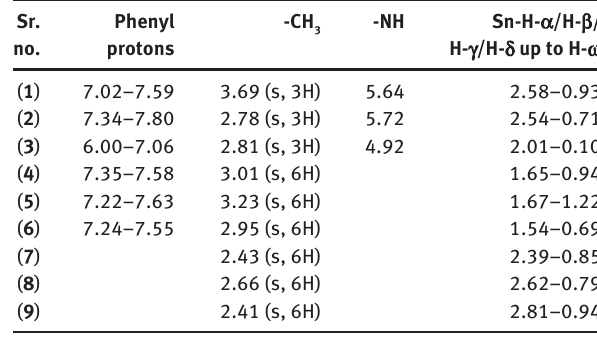
Table 3 1 H NMR chemical shifts ( δ , ppm) of di- and